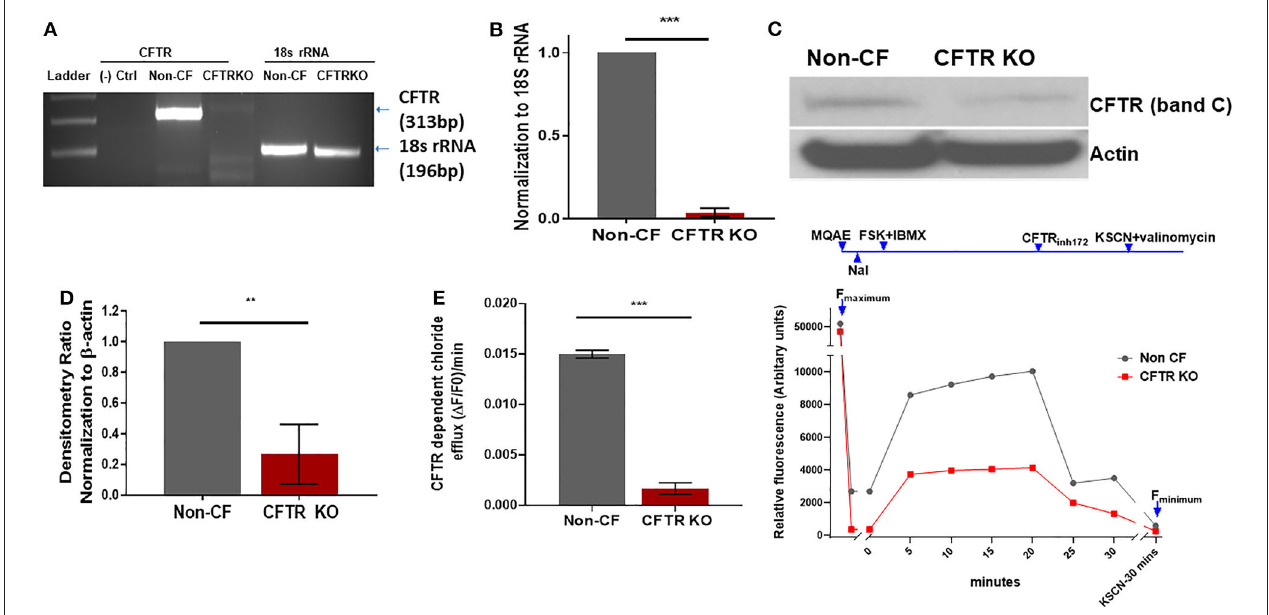
FIGURE 2 | CFTR changes in CFTR KO model. (A) Representative semi-quantitative RT-PCR for CFTR and (B) corresponding quantitative summary of CFTR RT-PCR in CFTR KO and non-CF MDMs, n = 3, mean ± SD. (C) Representative CFTR western blot (Abcam CF3 2784) and (D) summed densitometry of CFTR KO western blots in CFTR KO and non-CF MDMs, n = 3, mean ± SD. (E) MQAE halide efflux assay of CFTR dependent chloride efflux as measure of CFTR function in non-CF and CFTR KO MDMs, n = 6. Maximal fluorescence after forskolin stimulation shown. Representative time course also shown with annotations for forskolin plus IBMX stimulation (FSK + IBMX), CFTR inhibition (CFTRinh172), and quenching with KSCN plus valinomycin. ** p < 0.01, *** p < 0.001, via unpaired t -test, mean ±